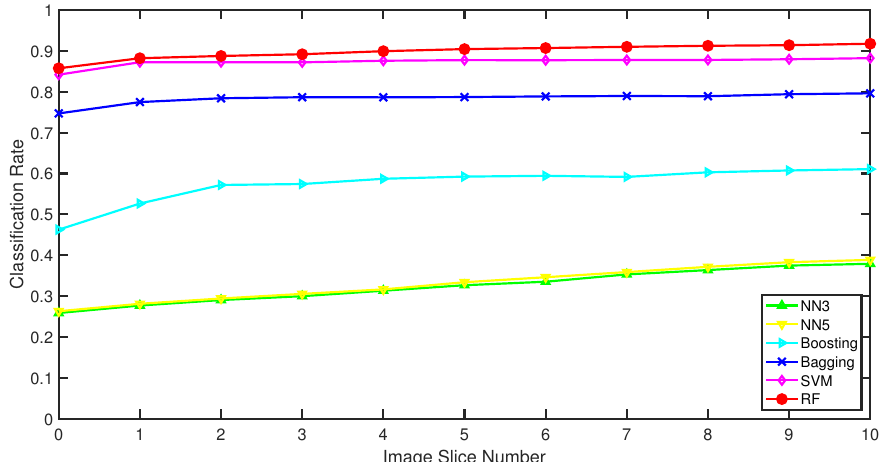
Figure 9. This figure demonstrates the classification rate of the four categories of WiFi signals based on the various image slice numbers via different classifiers.